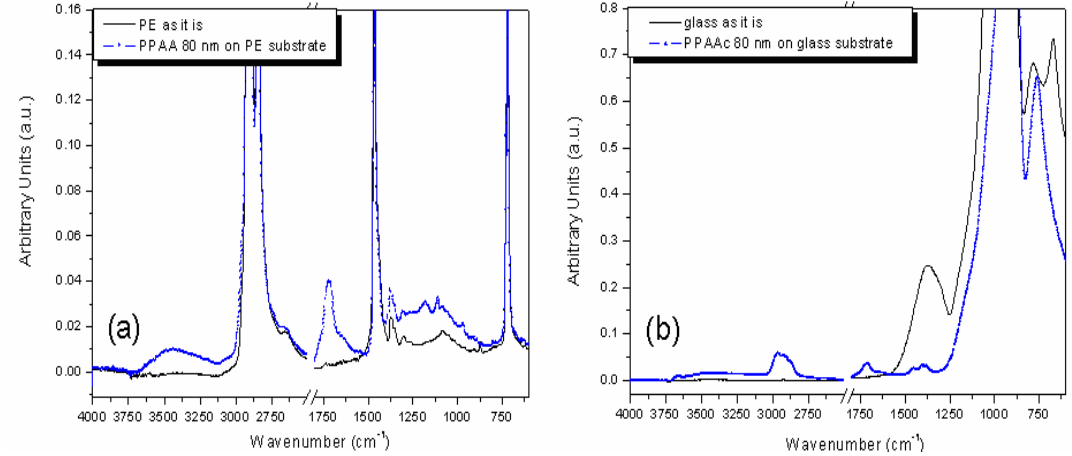
ddH O 30 min. rinsing. ( b ) ATR FT-IR spectra measured on bare glass and PPAA-glass 2 substrate after ddH O 30 min. 2